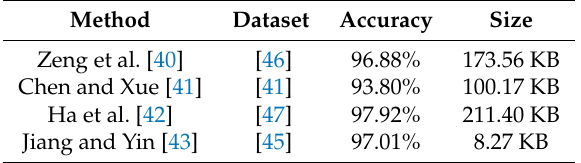
Table 3. Summary of the previous DCNN-based human activity